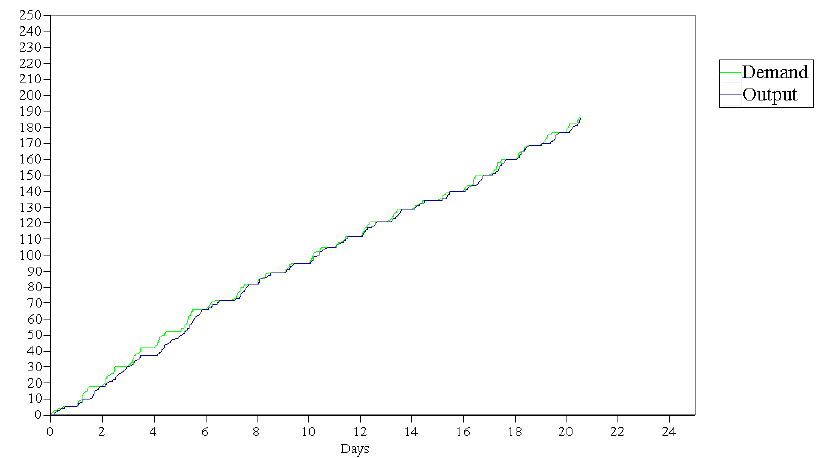
Figure 10. Supply and demand of the simulation model created for the improvement scenario where a second shift is enabled.